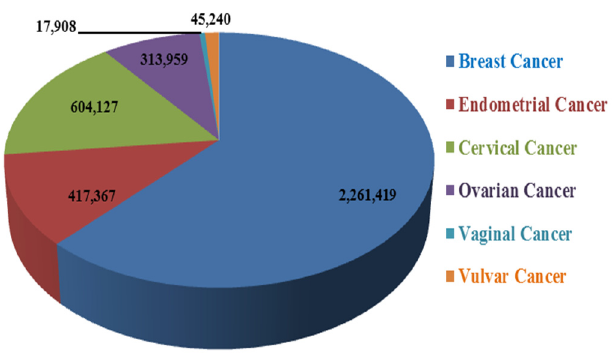
Figure 1. Worldwide incidence of female-oriented cancers according to WHO calculations.